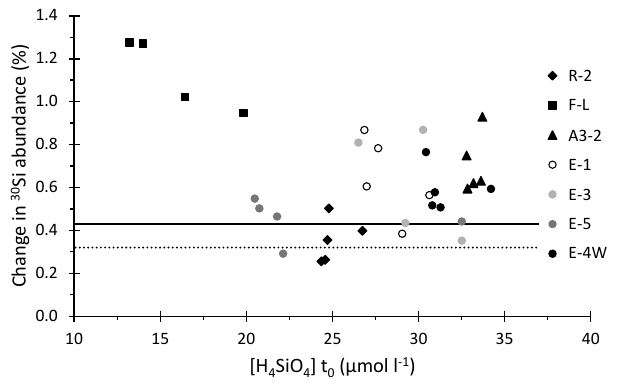
Figure 2. Comparison of changes in 30 Si abundance of seawater for each incubation (symbols) with detection limit of the 30 Si isotopic dilution method (solid line) estimated from the reproductibility of an internal standard (0.43%, n = 40). The dotted line represents the detection limit obtained from the average reproductibility of all dis- solution duplicates (0.32%, n = 35).